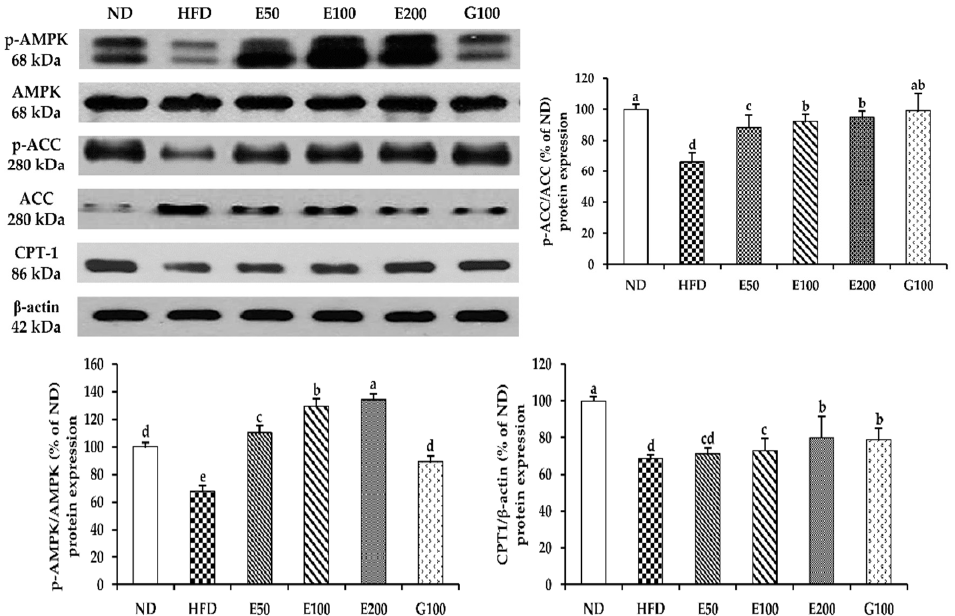
Figure 4. Effects of EAW on the levels of adipogenesis-related proteins in the liver. The liver was homogenized, and lysates were subjected to western blot analysis for PPAR γ , C/EBP α , and adiponectin. The intensity of each band was quantified using ImageJ. Values and is expressed as mean ± SD ( n = 3). Different lowercase alphabets indicate that differences between means were considered statistically significant when p < 0.05. ND, normal diet mice group (10% fat); HFD, high-fat (60% fat) diet-induced obese mice group; E50/100/200, high-fat diet-induced obese mice were orally treated with Erigeron annuus (L.) Pers. water extract (EAW) at concentrations of 50/100/200 mg/kg/day; G100, high-fat diet-induced obese mice were orally treated with Garcinia cambogia water extract at concentrations of 100 mg/kg/day.